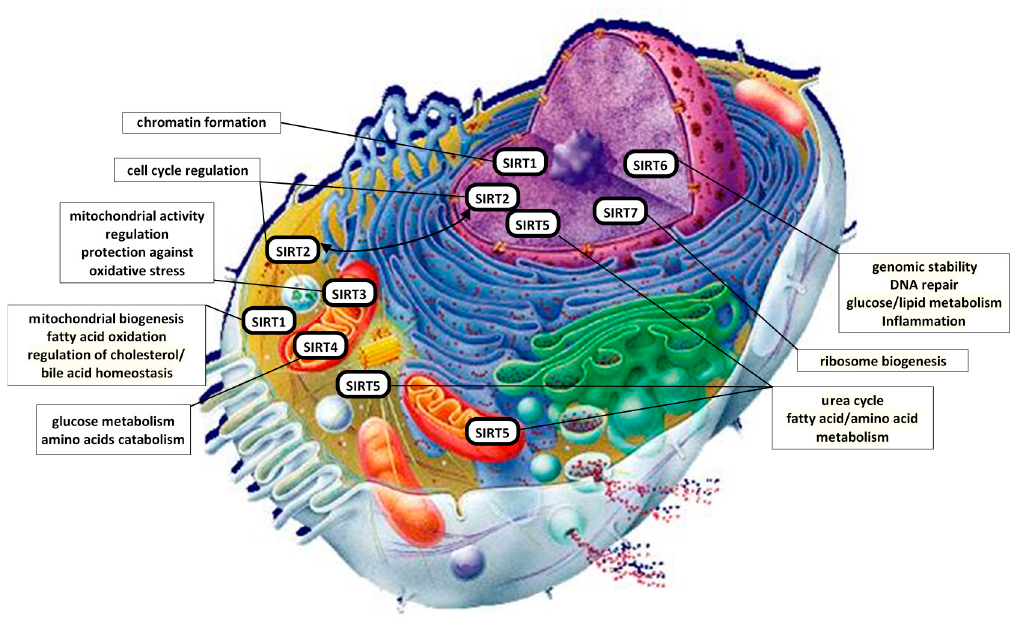
Figure 3. Cellular localization and main cellular mechanisms in which SIRTs participate